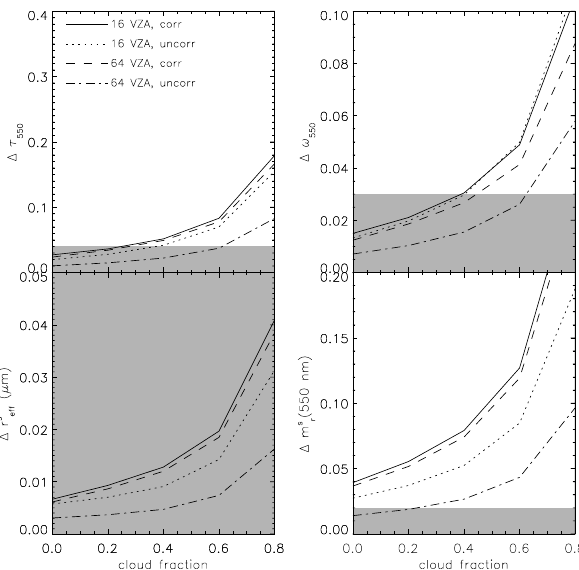
Fig. 6. Retrieval error on the aerosol optical thickness (upper left panel), single scattering albedo (upper right panel), fine mode effec- tive radius (lower left panel), fine mode real refractive index (lower right panel), as a function of cloud fraction for a situation with a biomass burning aerosol layer with AOT=0.5 situated between 0– 2km, below a partially clouded scene with a cloud layer between 2– 3km. Simulations have been performed for a relative azimuth angle 1ϕ = 0 ◦ . Multi-angle photo-polarimetric measuremenst have been considered with respectively 16 and 64 viewing angles, and with a polarimetric accuracy of 0.002 and a radiometric accuracy of 2%. Both uncorrelated and correlated errors have been